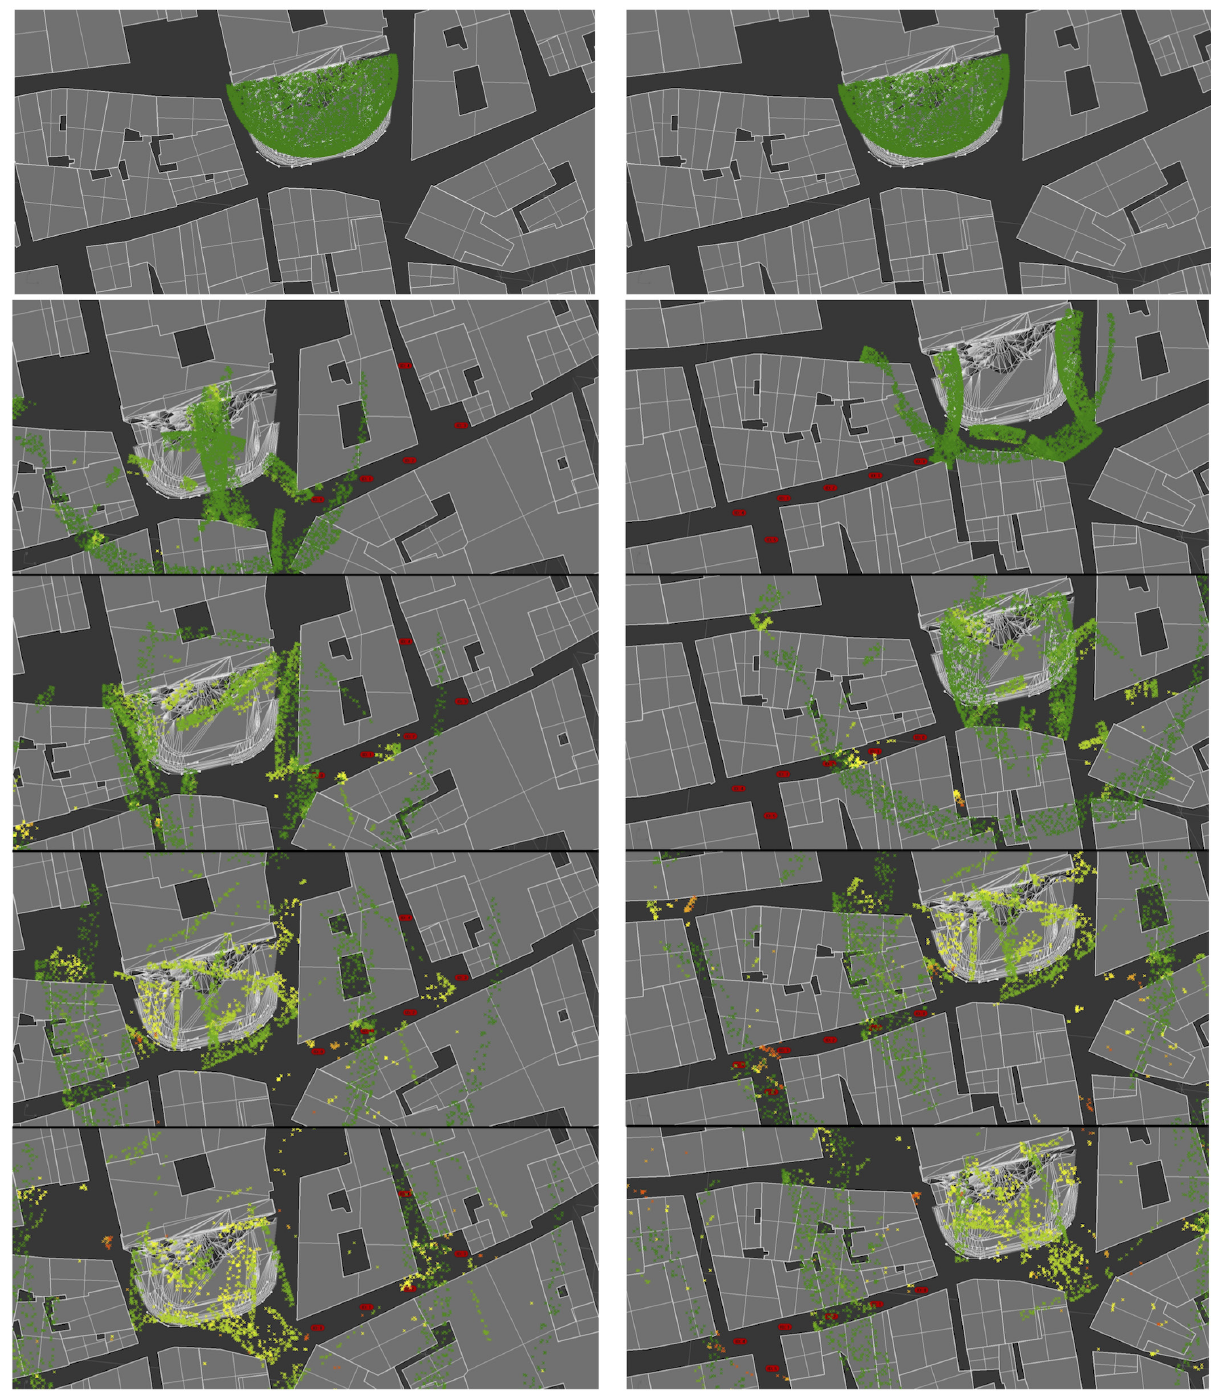
Figure 12: ( A ) Ray-tracer simulations showing the particles entering in Via del Lavatore, where the red dots are visible. Frames taken, from top to bottom, after 16-39-57-70-85 milliseconds. ( B ) particles entering Via delle Muratte, frames taken, from top to bottom, after 16-27-49- 70-80 milliseconds. The top frames show the source at the start of sound, i.e. , particles are shown only 16 milliseconds after the start. The wave front is still a hemisphere, since it has not bounced on any surface or